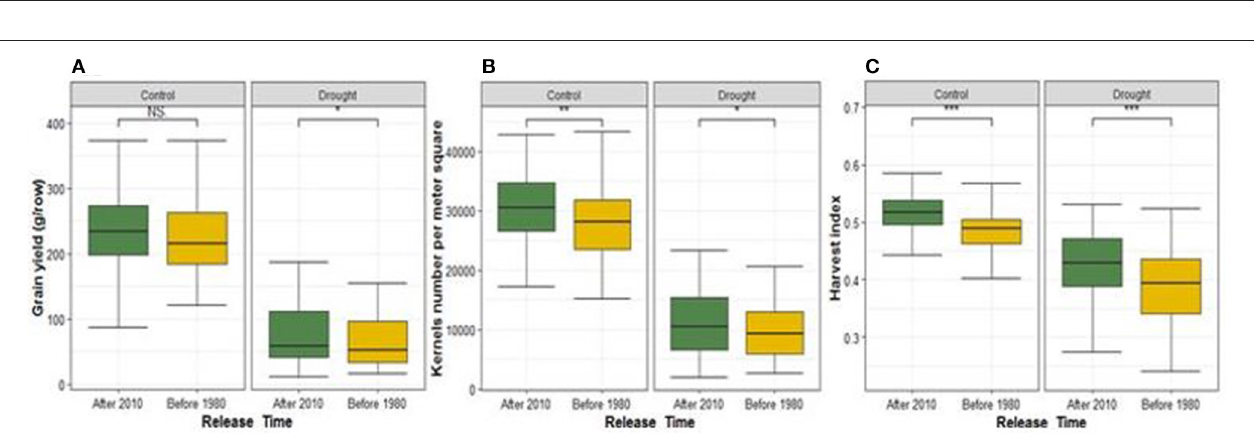
FIGURE 1 | Regression plots showing breeding progress in agronomic traits on Blues values for two growing seasons. Each dot represents a BLUE value of a cultivars and the colored area represents the confidence interval of the regression line. The slopes of the linear regression lines (green lines for rainfed conditions and orange values for droughts stress field) are referred to absolute breeding progress and the relative breeding progress is the ratio between the values in 2010 and 1980 as show in Supplementary Table 4 . (A–C) are breeding progress in GY, KN, SDW, respectively. The abbreviations of traits names are given in the legend of Table 1 .